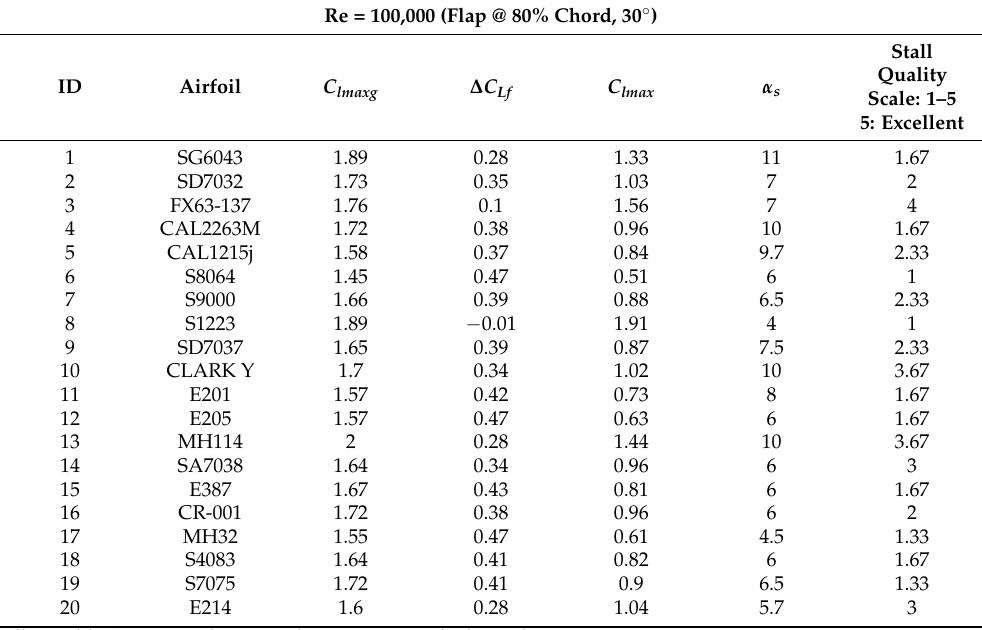
All variables’ units are dimensionless, except C m units which are 1/rad and α i and α s which are degrees. Table 9. Measurements of interest at Re = 100,000 and 30 ◦ flap deflection at 80% of